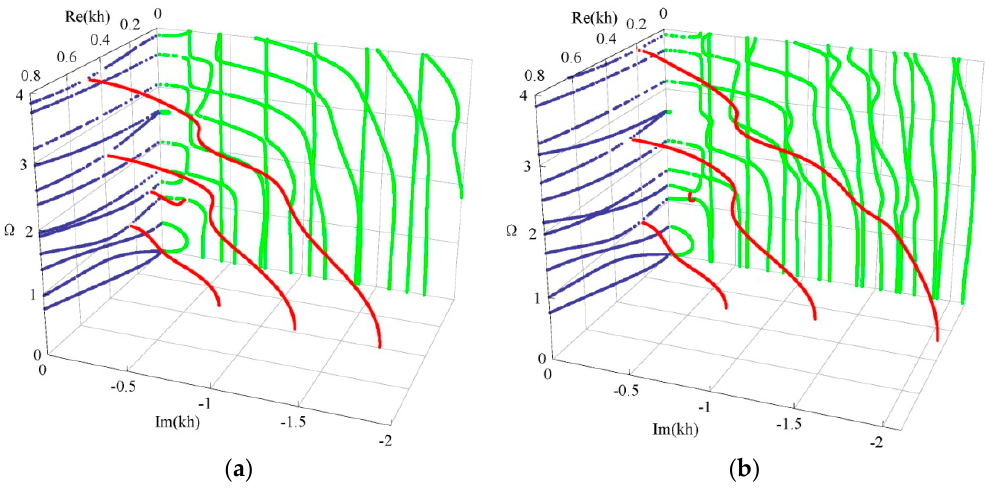
Figure 7. 3D dispersion curves of Lamb wave: ( a ) cubic graded field, ( b ) sinusoidal graded field. blue—real branches, green—purely imaginary branches, red—complex branches.